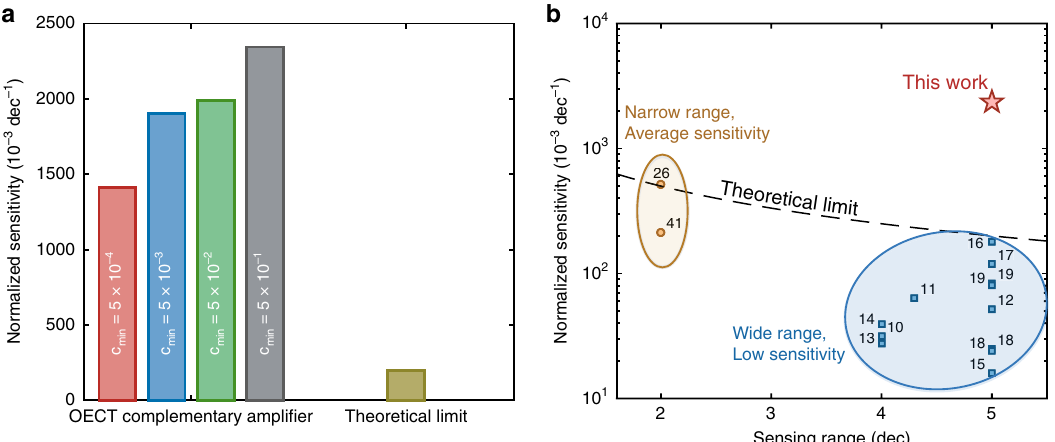
Fig. 8 Sensing performance benchmark. a Normalized Sensitivity S N of the organic electrochemical transistor complementary ampli fi er compared with the theoretical limit for ion detection over 5 orders of magnitude. The S N for the complementary OECT ampli fi er is equal to [1414,1904,1990,2344] mV V − 1 dec − 1 when c min is equal to [5.4 × 10 − 4 5.4 × 10 − 3 5.4 × 10 − 2 5.4 × 10 − 1 ] M, respectively, while the theoretical fundamental limit is equal to 200 mV V − 1